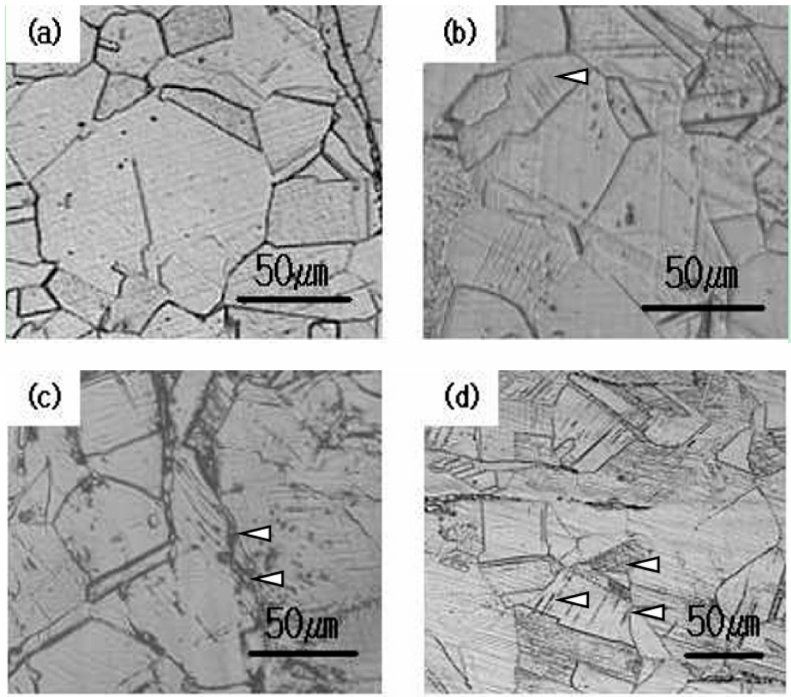
Figure 3. Optical micrographs showing α (cid:48) -martensite in the specimens after low-cycle fatigue failure under various strain amplitudes: ( a ) as-received specimen; ( b ) 1.1% ( N f = 578); ( c ) 1.4% ( N f = 342); and ( d ) 1.7% ( N f = 182).